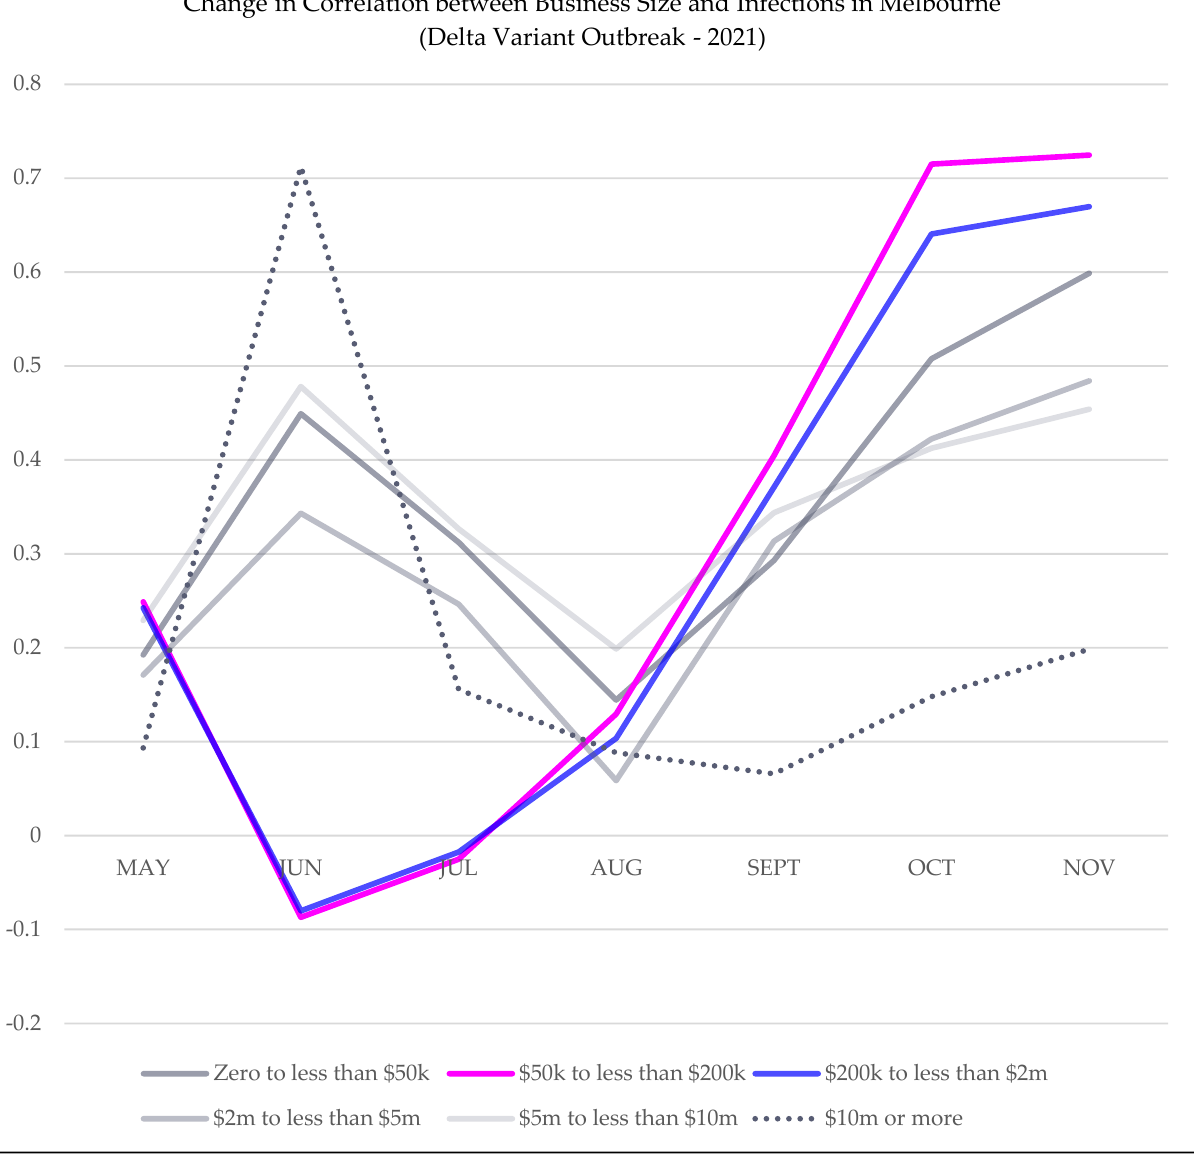
Figure 11. The changing risk profile of construction businesses over the duration of the outbreak of the Delta Variant in Melbourne.